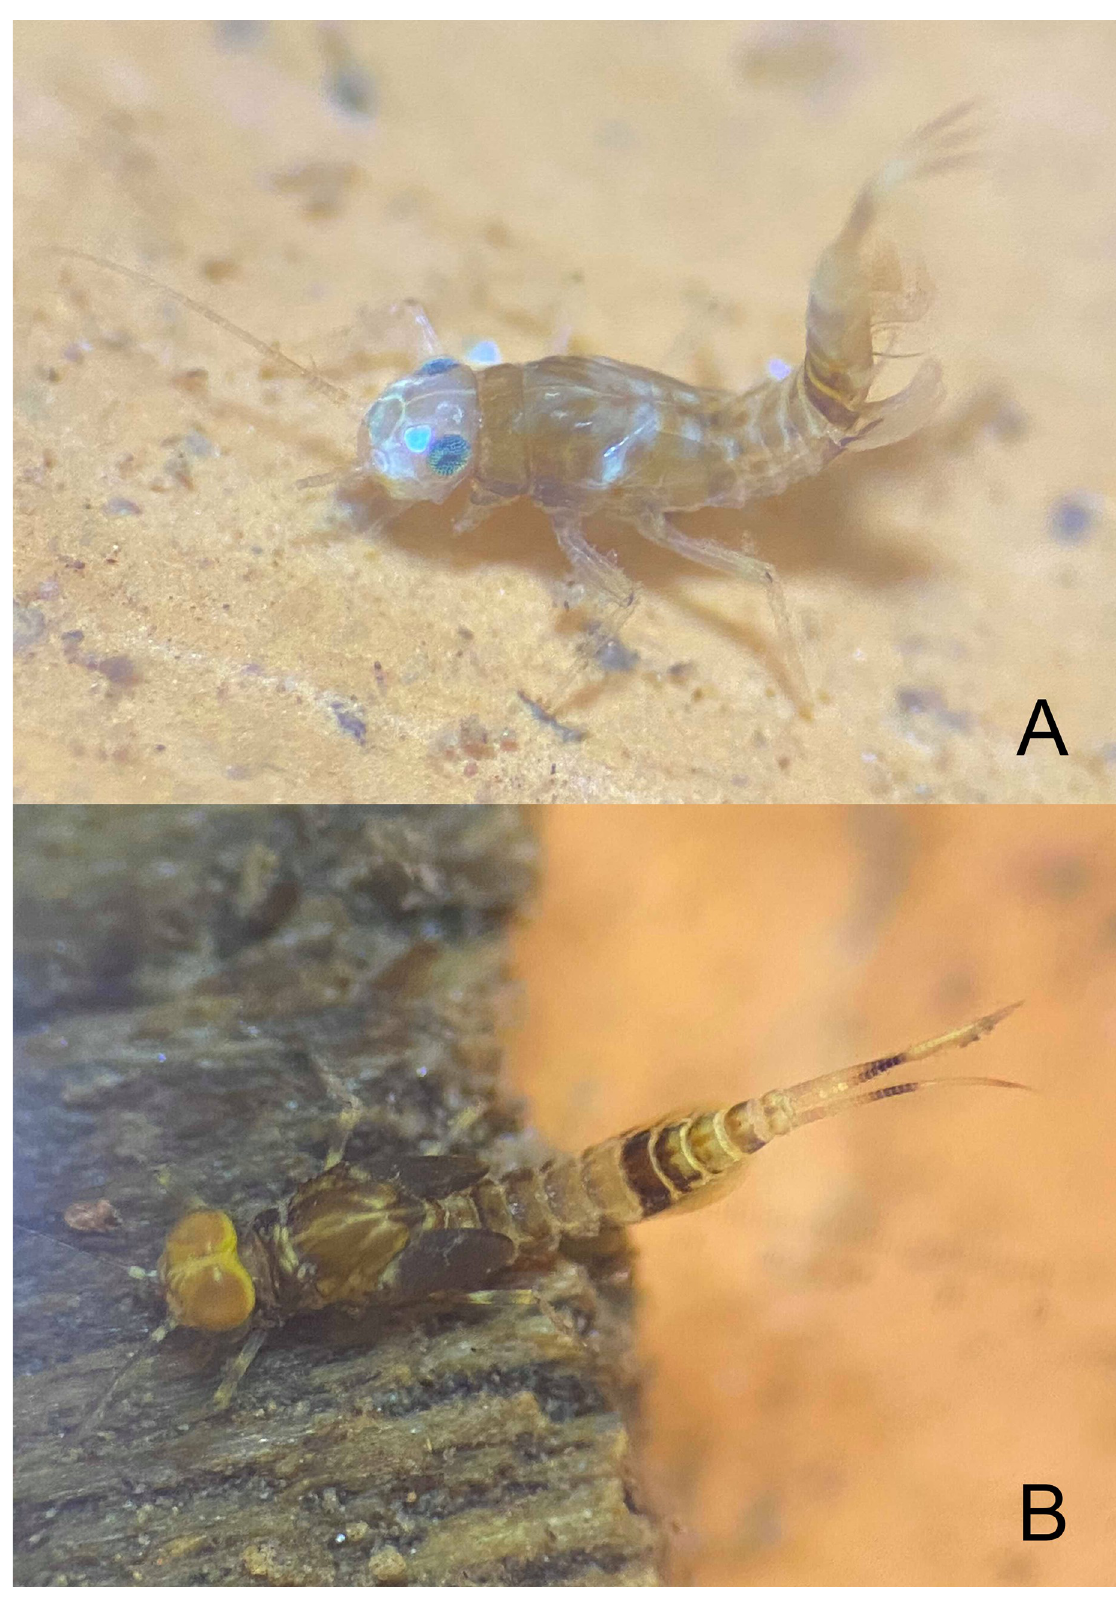
Fig 3. Cymbalcloeon sartorii gen. nov. et sp. nov. Larva habitus. (A) female larva, (B) male mature larva. https://doi.org/10.1371/journal.pone.0240635.g003 PLOS ONE | https://doi.org/10.1371/journal.pone.0240635 October 13,